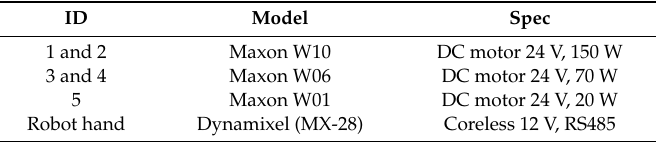
Table 4. Specifications of grasping